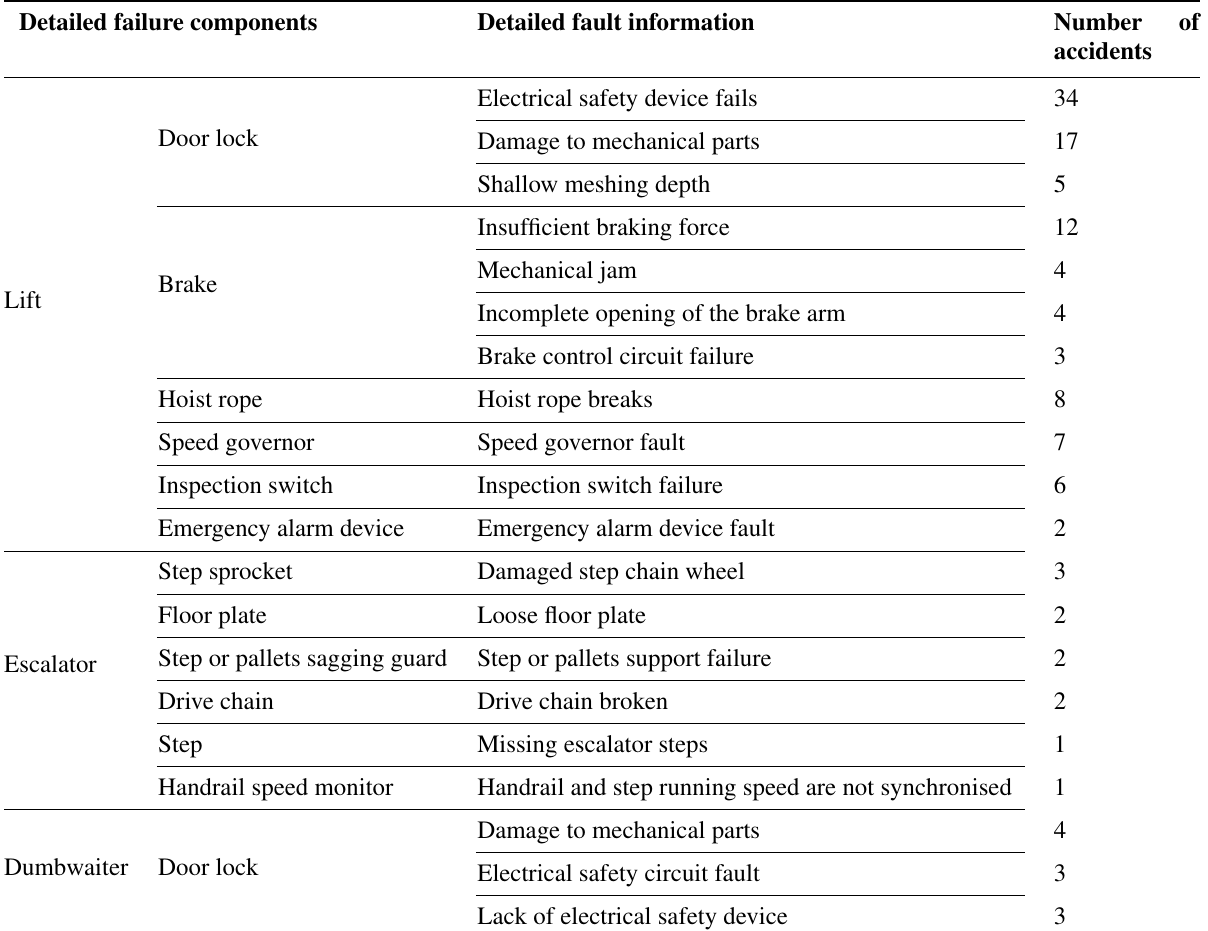
Table 6 Defective equipment component